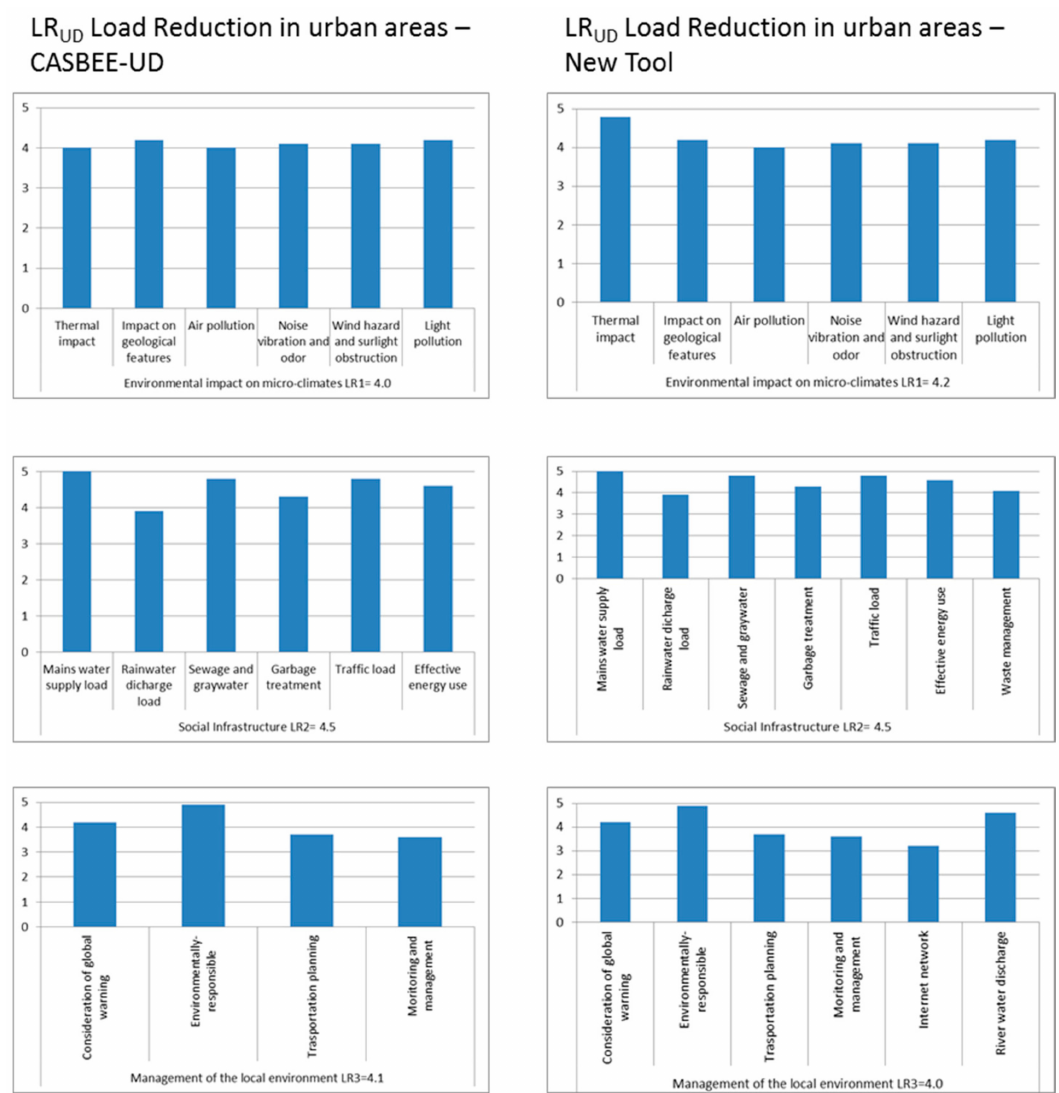
Figure 4. Comparison results of Load Reduction (LR UD